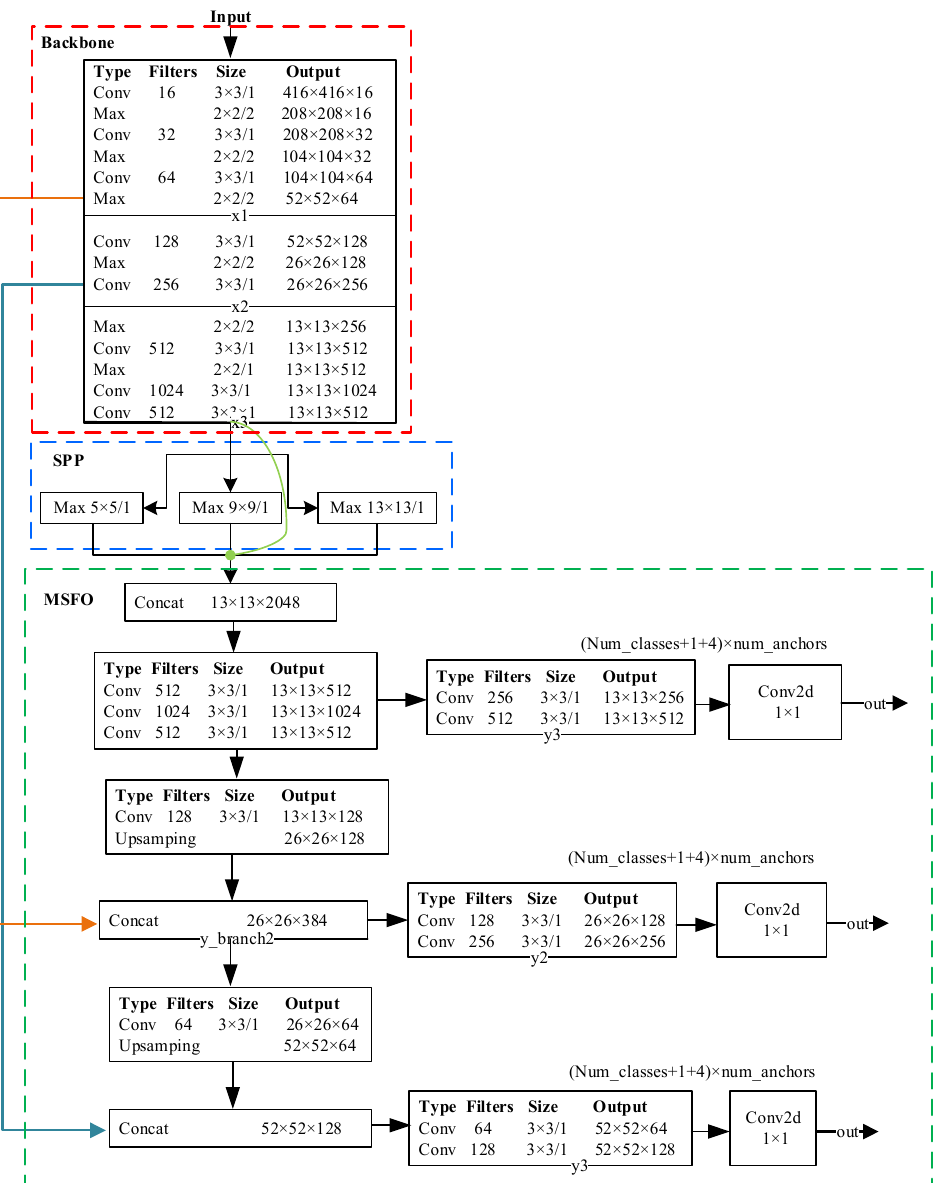
Figure 2. Structure of the SPP-MSFO